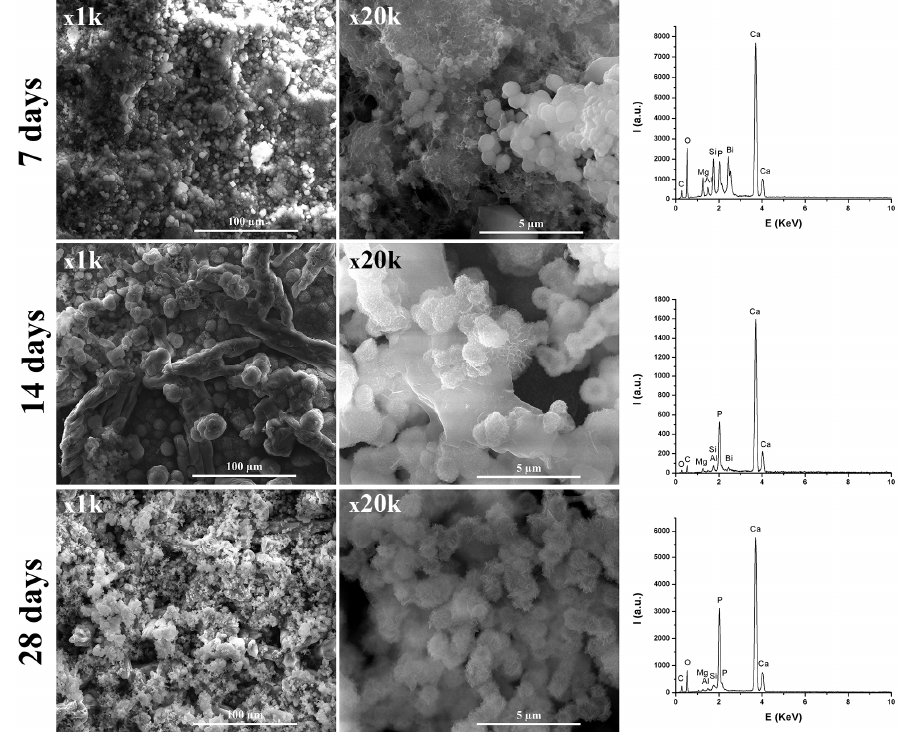
Figure 9 . Scanning electron micrographs at different magnifications and elemental analysis of the Figure 9. Scanning electron micrographs at di ff erent magnifications and elemental analysis of the BIO BIO MTA+ surface showing mineralization at 7, 14, and 28 days. MTA + surface showing mineralization at 7, 14, and 28